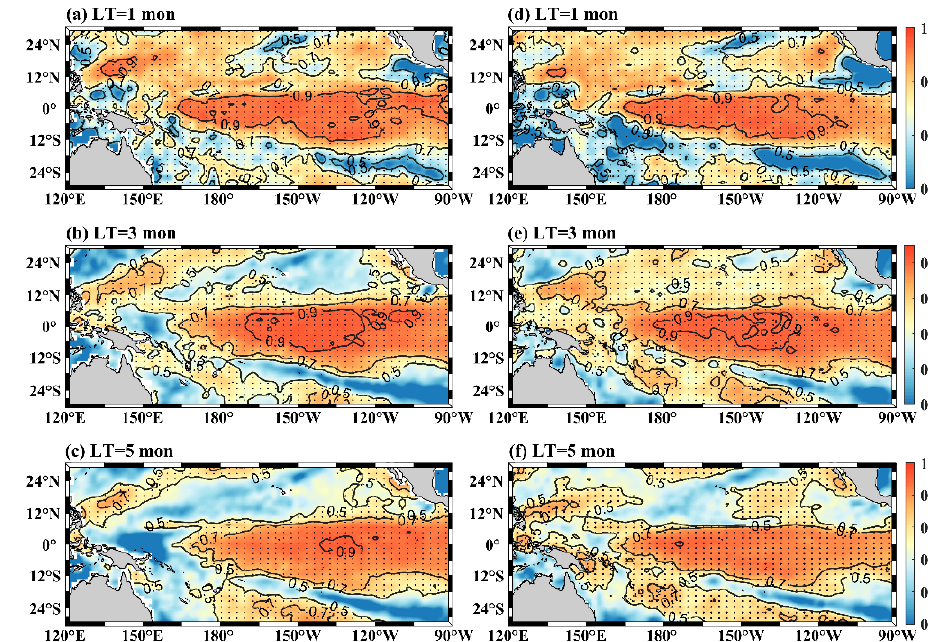
Figure 1. Spatial distribution of temporal correlation predictive skill scores (shading, unit: 1) of the boreal winter SSTAs at ( a , d ) 1-month, ( b , e ) 3-month, and ( c , f ) 5-month lead times for FIO − ESM − CPS (left panels), for modified FIO − ESM − CPS (right panels). Stipples denote values passing the 1% significance level.